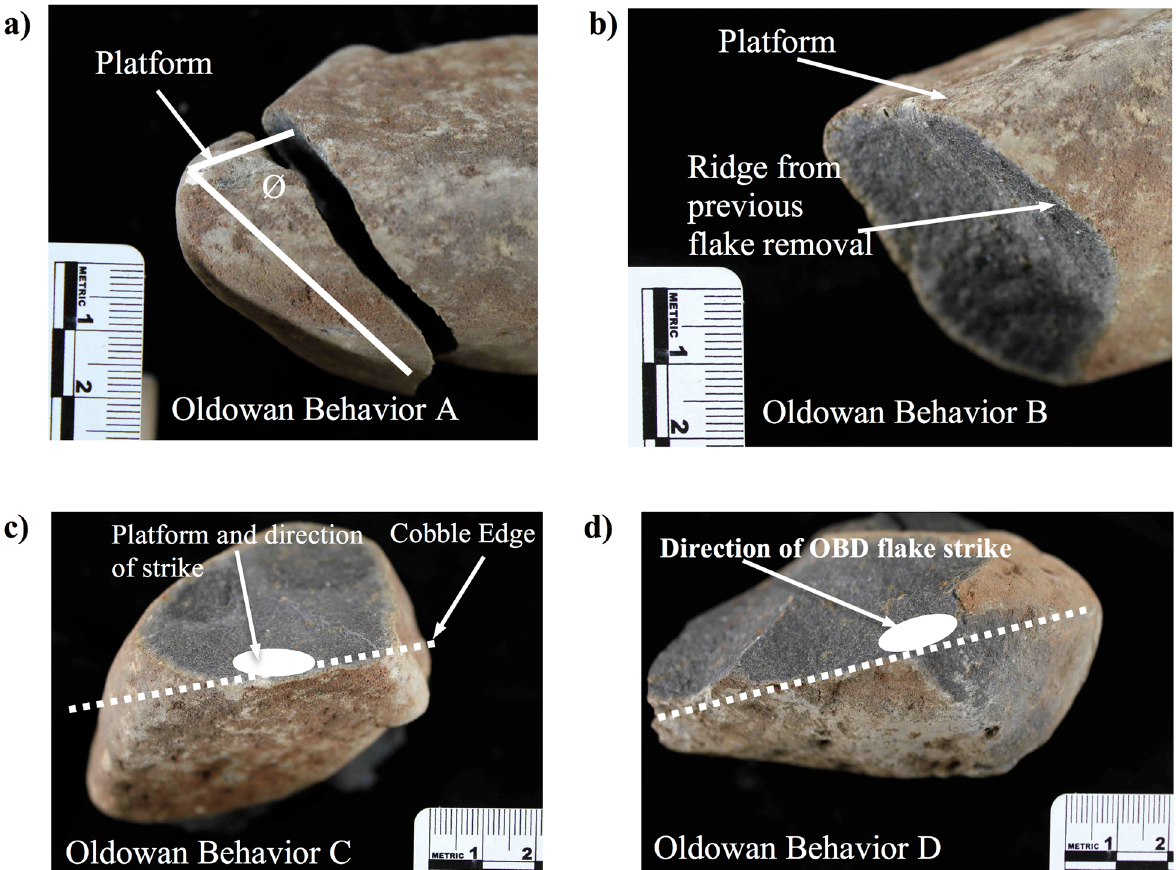
Fig 2. Oldowan production behaviors A-D. a) The primary prerequisite knowledge for flake production is the identification of an appropriate platform. Oldowan Behavior A (OBA) is the identification of an acutely angled edge on the cobble. b) Oldowan Behavior B (OBB) requires placement of a platform above a scar made from a previously removed flake (such as an OBA flake, though the process assumes no particular order in behaviors). c) Oldowan Behavior C (OBC) is bifacial flaking, using the noncortical surface produced from previous flake scars as the platform for the flake. d) Oldowan Behavior D (OBD) requires an obliquely struck flake relative to the cobble ’ s edge (represented by the dotted white line). Striking in such a direction removes a flake along the perimeter of the core instead of removing a flake toward the center of the core (as in OBC